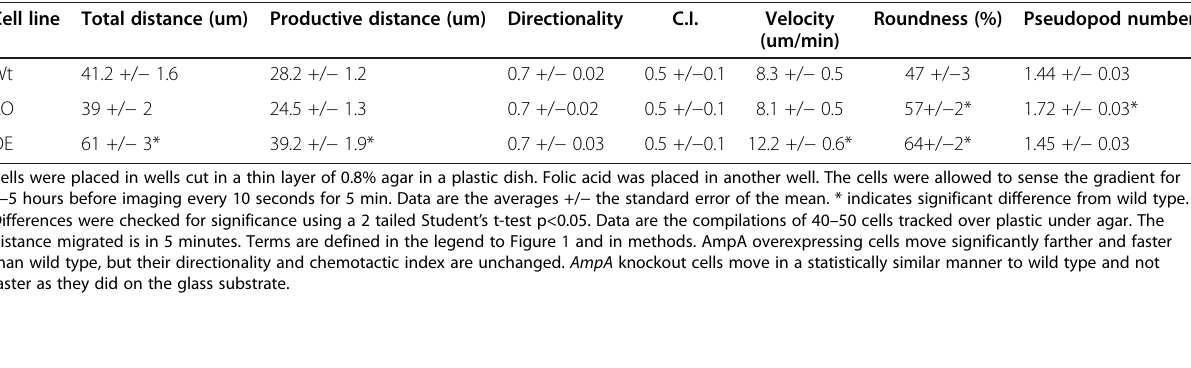
Table 2 The substratum plays a role in the effect of AmpA on cell migration Cell line Total distance (um) Productive distance (um)